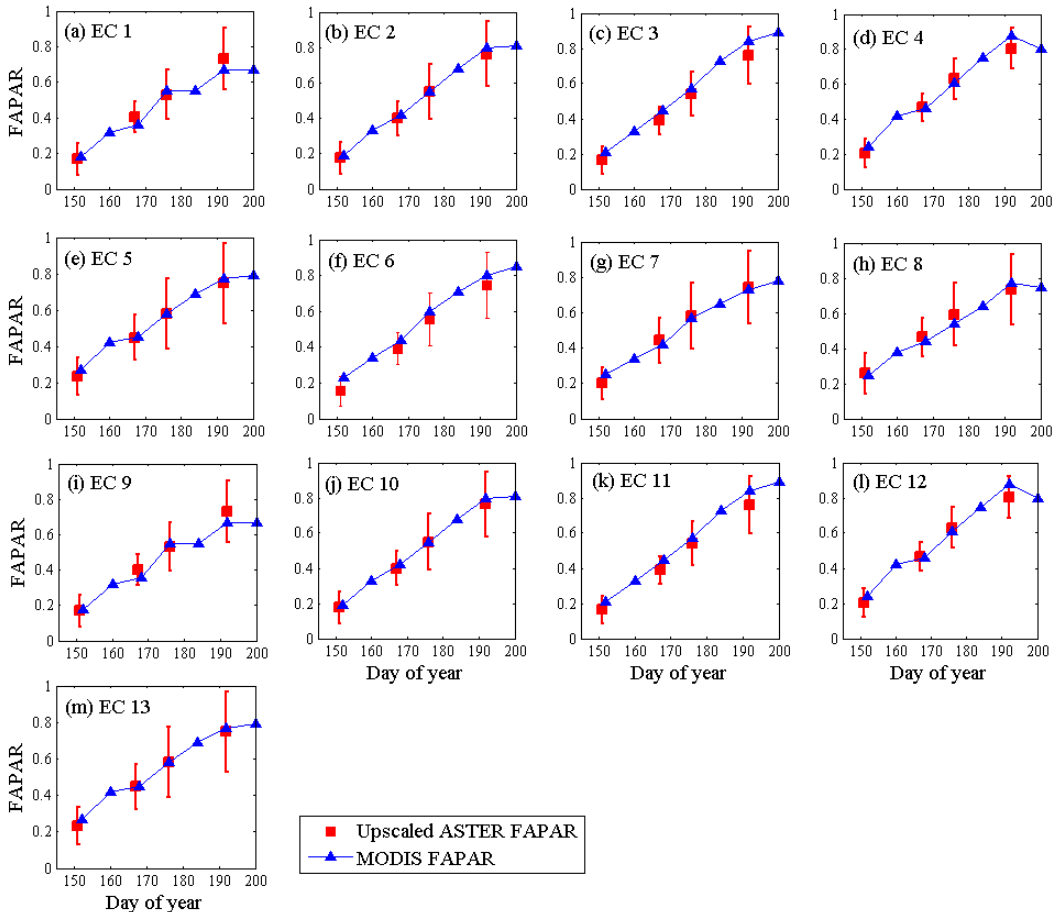
Figure 14. ( a – m )Time series of MODIS FAPAR compared to the upscaled ASTER FAPAR at 13 in-situ sites (the bars represent one standard deviation (STD) of FAPAR values of ASTER pixels within the 1 km MODIS pixel